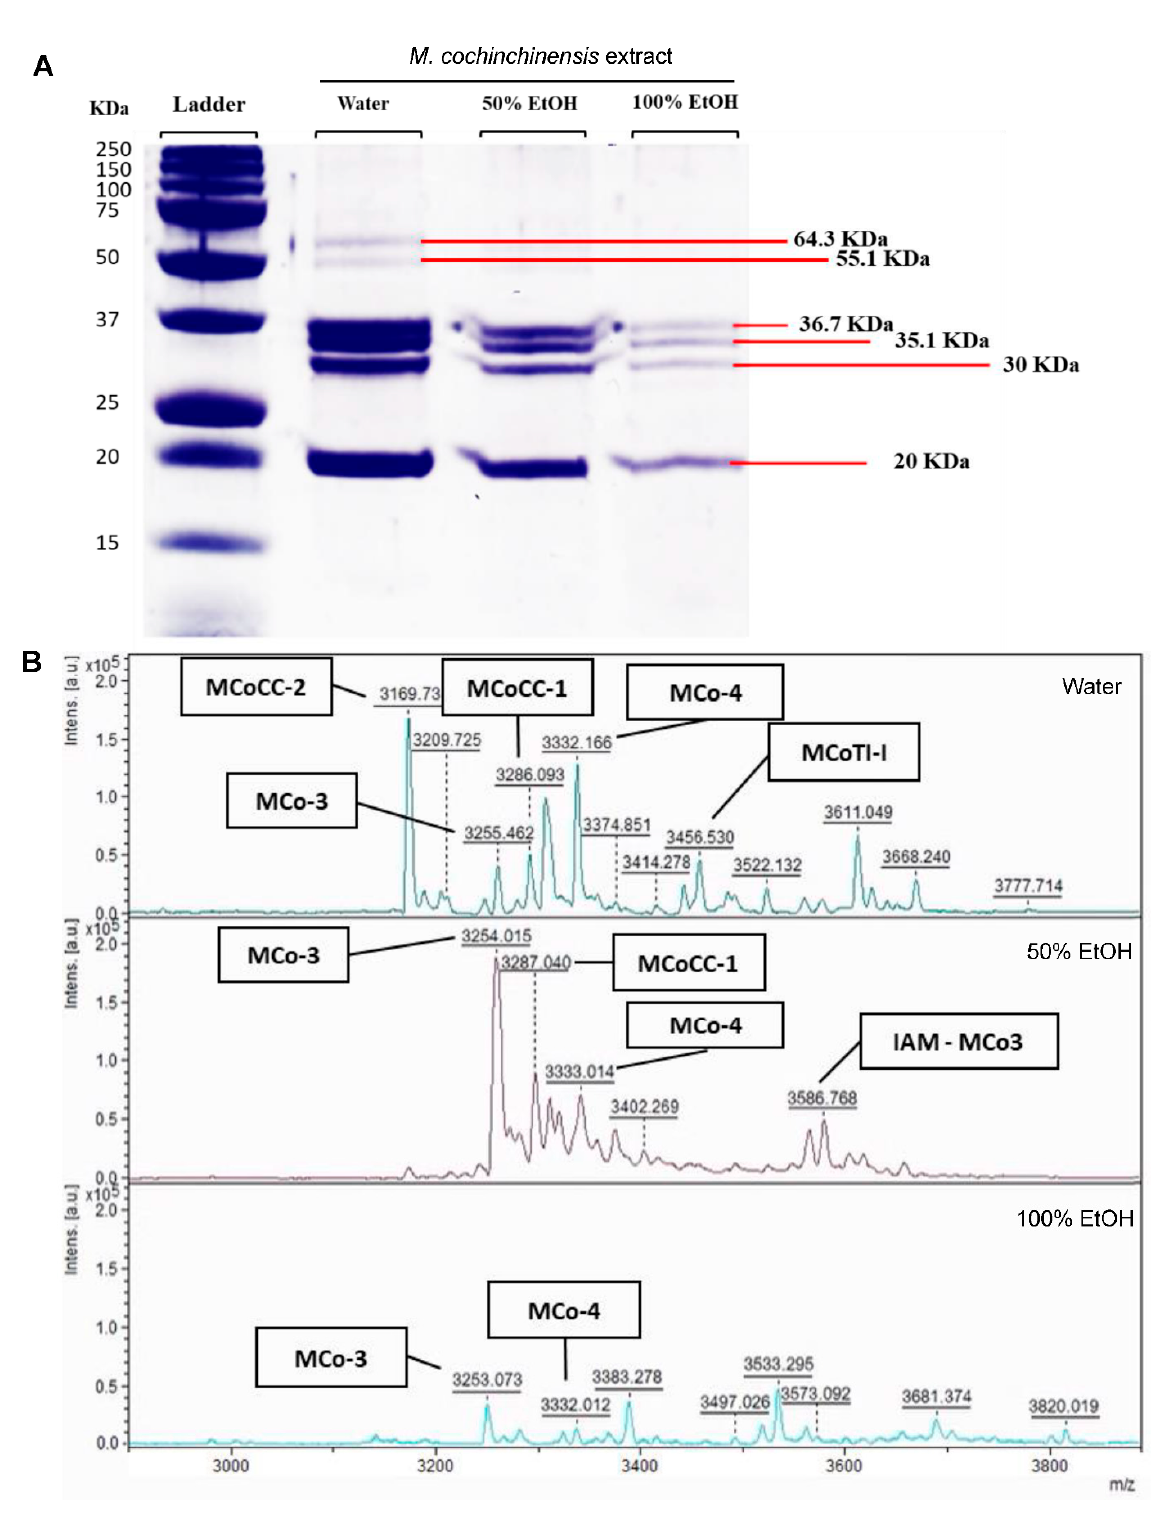
Figure 7. Protein ( A ) and peptide ( B ) profiles of M. cochinchinensis seed extracts. Mass spectra profiles of compounds between 1000 and 20,000 Da ranges were de- tected by MALDI-TOF. However, while there were no spectra peaks between 4000 and 20,000 Da (data shown in supplement documents), a number of peaks were recorded in the range between 3000 and 4000 Da. These peptides (3000 to 4000 Da) were detected for all solvents with the highest number of peptides and intensity observed in the water seed